Question: According to the figure, is the described quantity increasing or decreasing?
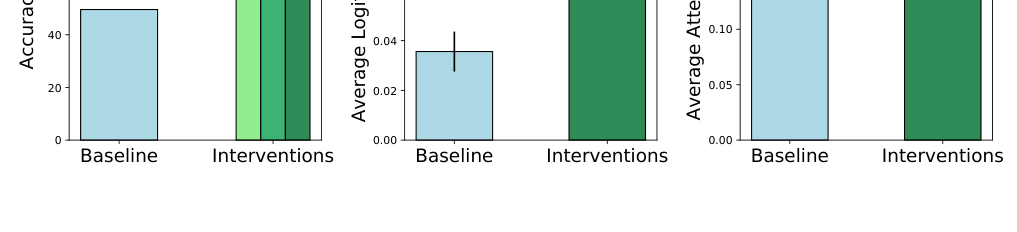
Answer: increasing